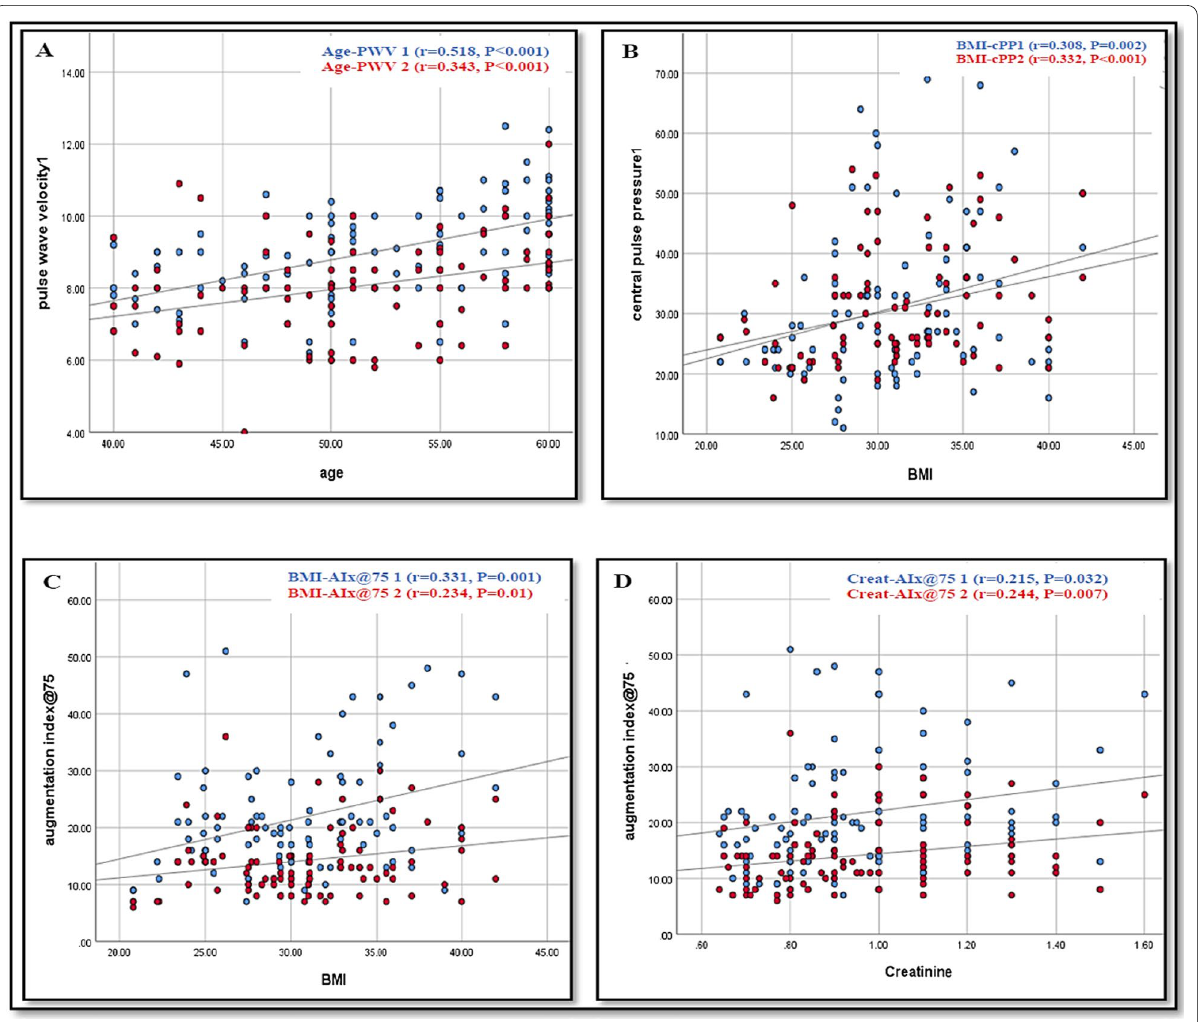
Fig. 1 Scatter plots illustrating the correlation of central arterial stiffness parameters with age, body mass index and serum creatinine. BMI, body mass index; PWV, pulse wave velocity; AIx, augmentation index; cPP, central pulse pressure; creat, creatinine. Blue and red dots indicate the correlation during the decompensated and compensated states, respectively. A significant positive correlation between age and pulse wave velocity. B Significant positive correlation between BMI and central pulse pressure. C Significant positive correlation between BMI and AIx@75. D Significant positive correlation between serum creatinine and